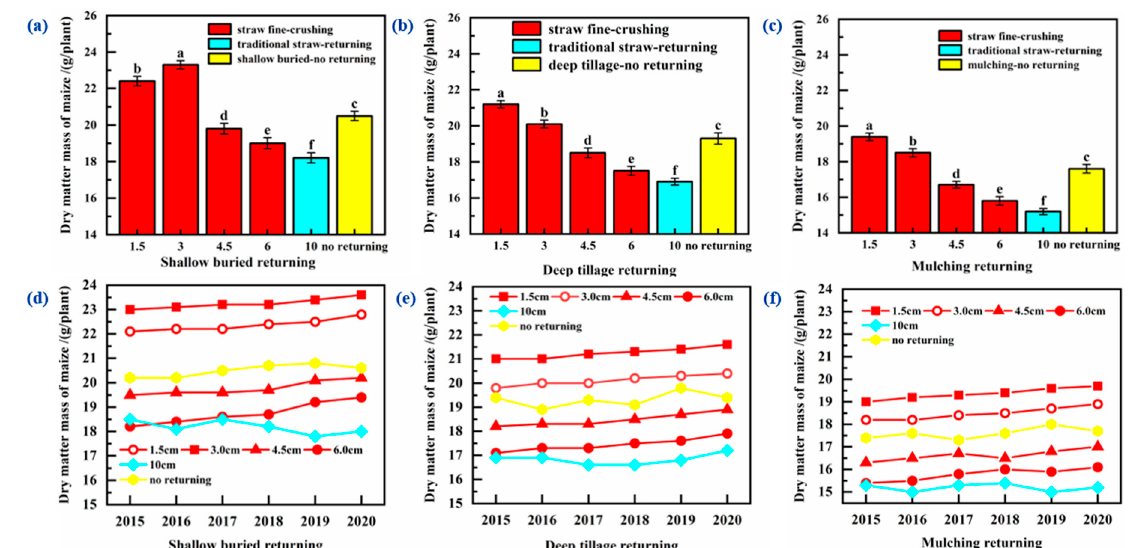
Figure 6. Six-year average of DMM shown in ( a – c ) and DMM values for each year shown in ( d – f ). Averages followed by different lowercase letters are significantly different according to LSD’s multiple-range experiment at the significance level of 0.05. Error bars are standard deviation.